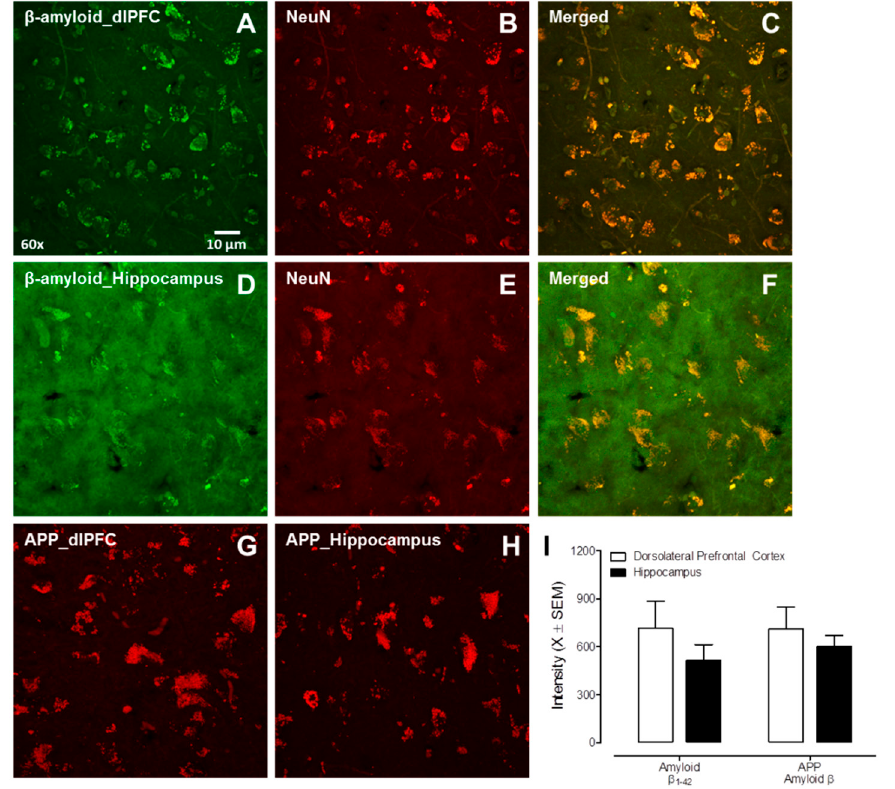
Figure 4. β -amyloid accumulation in the dorsolateral PFC (dlPFC) and hippocampal dentate gyrus from human autopsy HIV-infected cases with HAND. ( A – F ) Representative images of double staining of β -amyloid with NeuN (a neuronal marker) in the dlPFC ( A – C ), and in the hippocampus from human autopsy ( D – F ). ( G , H ) Confocal images of amyloid precursor protein expression in the dlPFC and hippocampus. ( I ) Quantification of β -amyloid and amyloid precursor protein expression in the dlPFC and hippocampus.